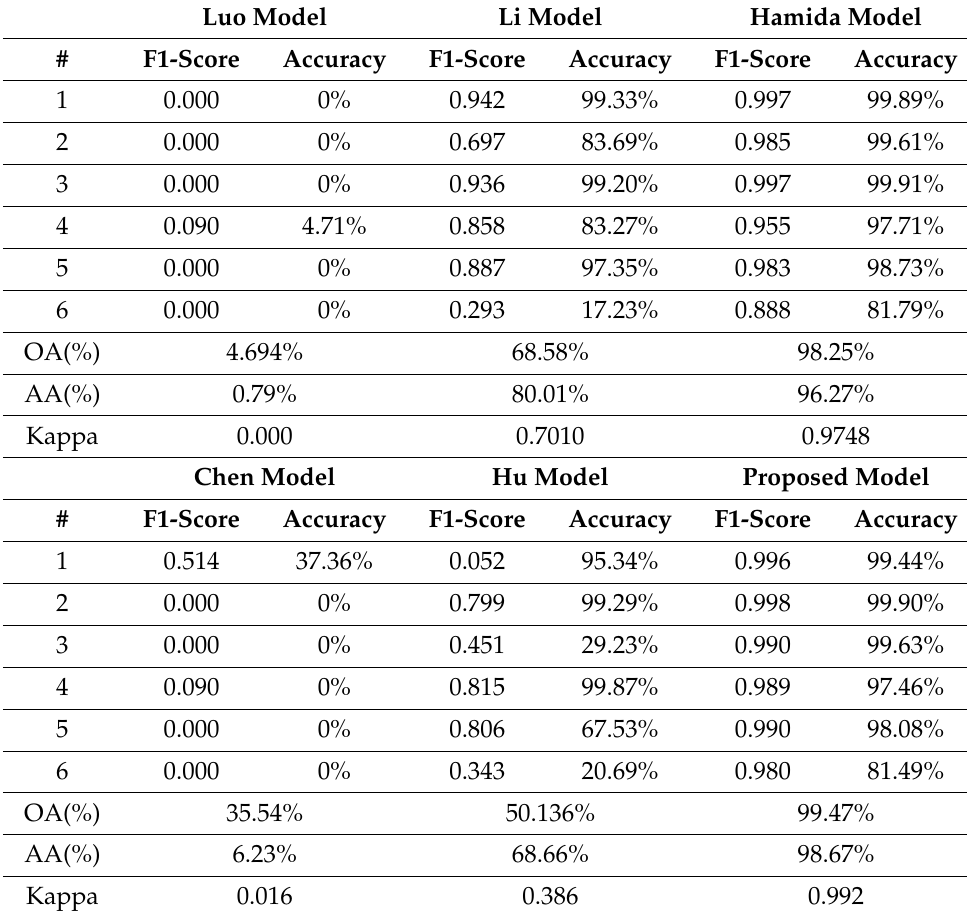
Table 9. Classification results of the YU Paint dataset to which random spatial information is not